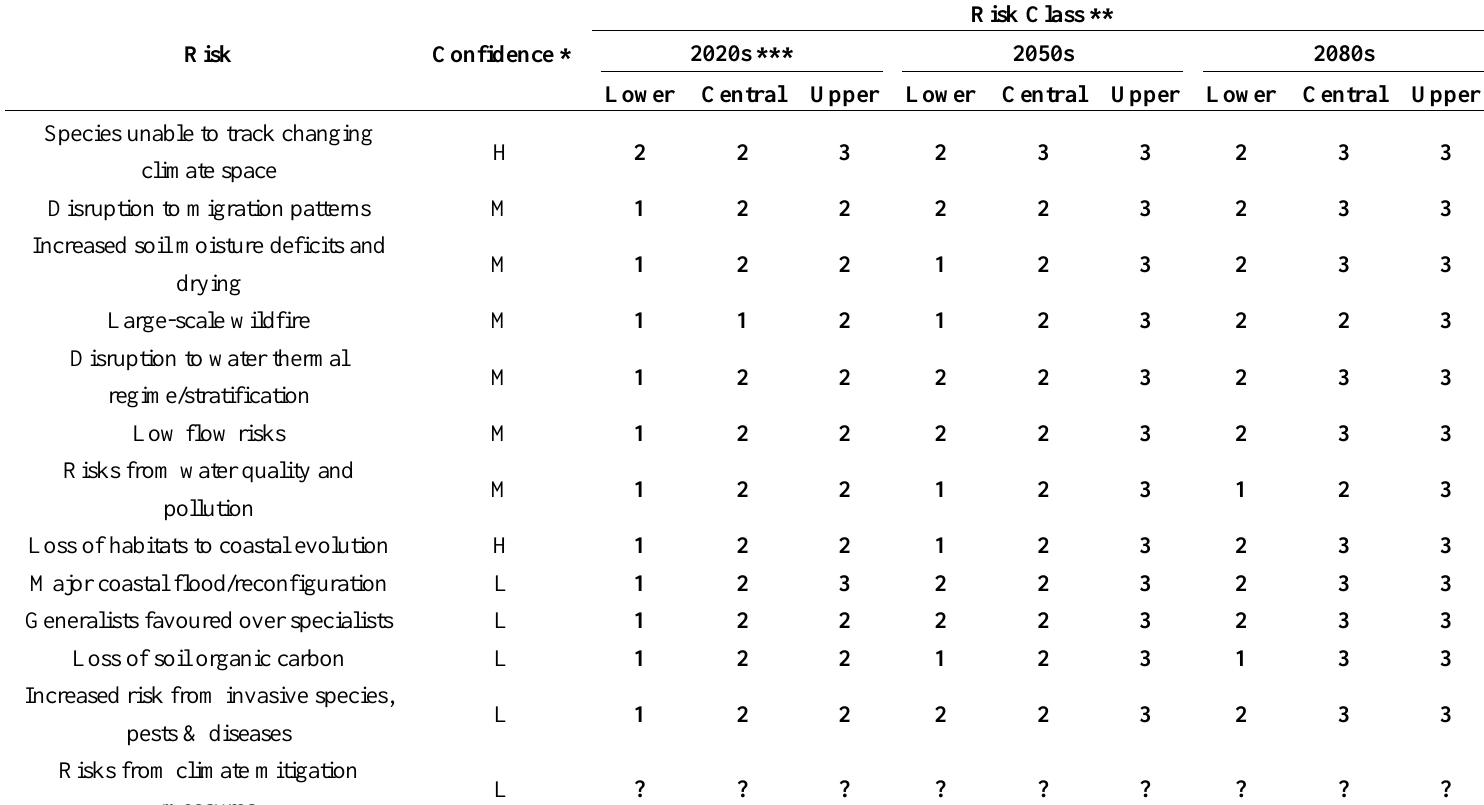
Table 3. Changing risk profile for priority risks with future time periods and different climate projections. Risk Confidence